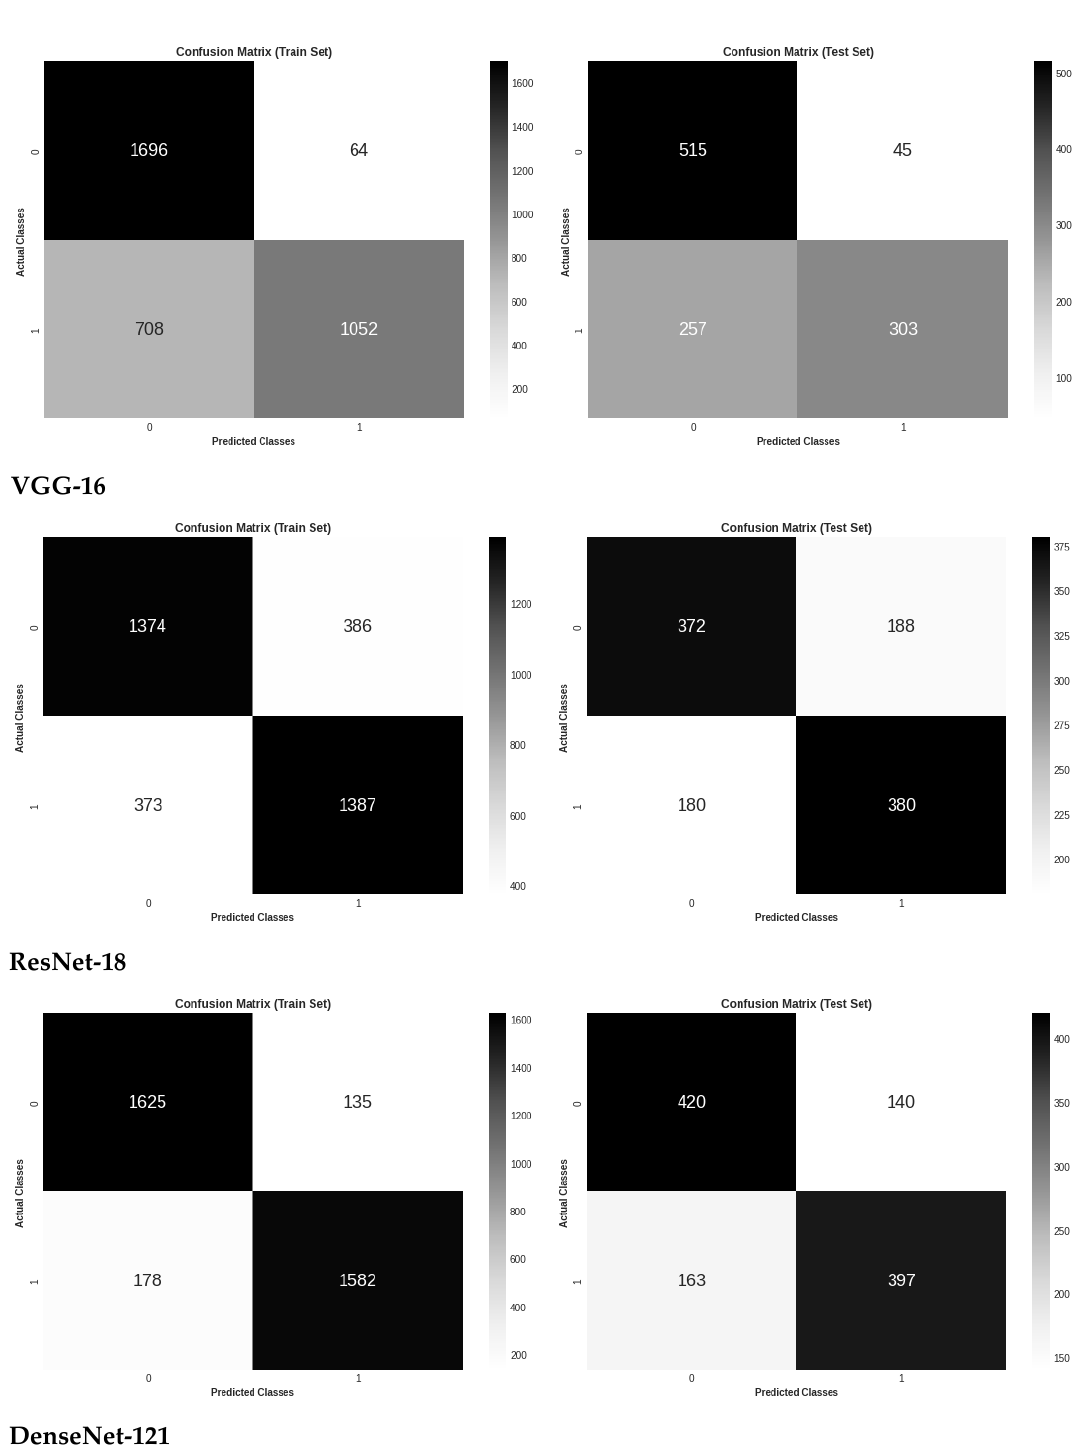
Figure 5. Confusion matrix evaluation of the three models on the test and train sets for binary classes classification. Table 3. Performance evaluation on the test and train sets for DR stages classification.